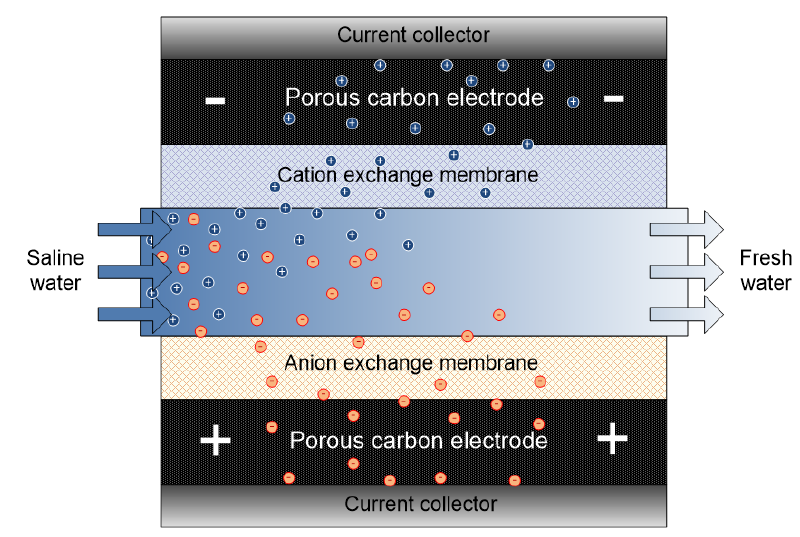
Figure 7. Schematic representation of membrane capacitive deionization (MCDI) system.